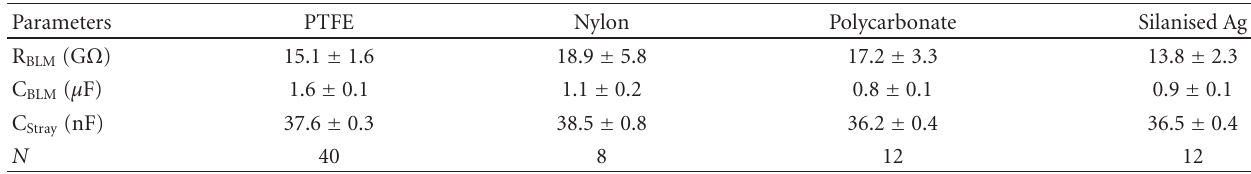
Values determined from fit of equivalent model circuit to the data. Data are mean ± S.E.M. R BLM : membrane resistance, C BLM : capacitance of the BLM, C Stray : stray